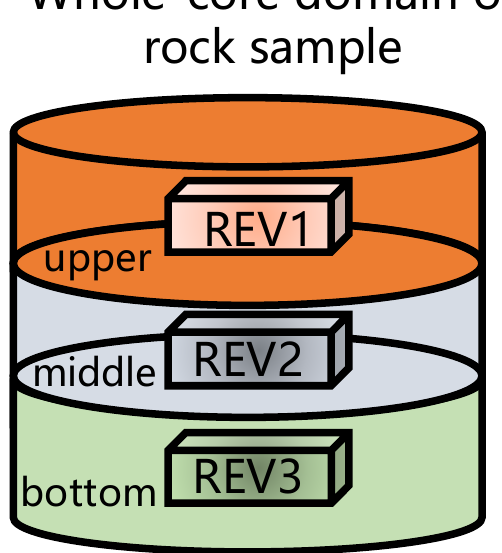
Figure 5. Schematic diagram of REVs oriented at three different subdomains (upper (orange), middle (gray) and bottom (green)) divided from a whole-core computational domain of CT-scanned rock sample.